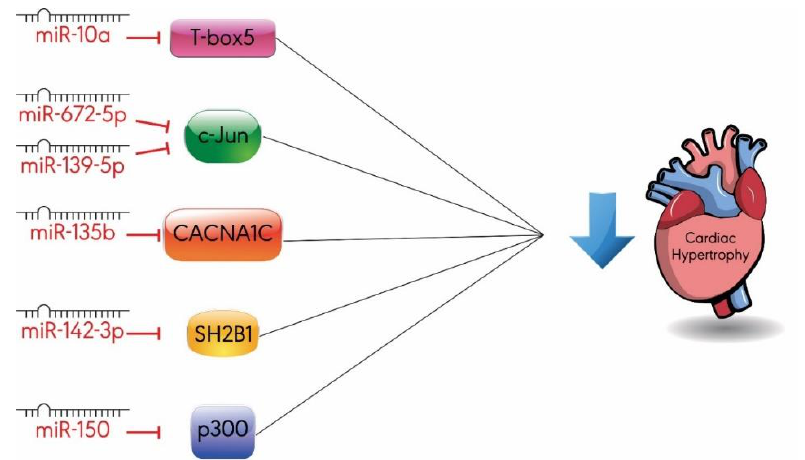
Figure 4. Anti-hypertrophic miRNAs ameliorate cardiac hypertrophy by targeting several biological pathways: miR-10a decreases the expression of T-box5; miR-672-5p and miR-139-5p inhibit c-Jun expression; miR-135b downregulates CACNA1C (L-type calcium channels); miR-142-3p inhibits SH2B1; miR-150 represses the expression of p300. SH2B1: Src homology 2 B adaptor protein 1.